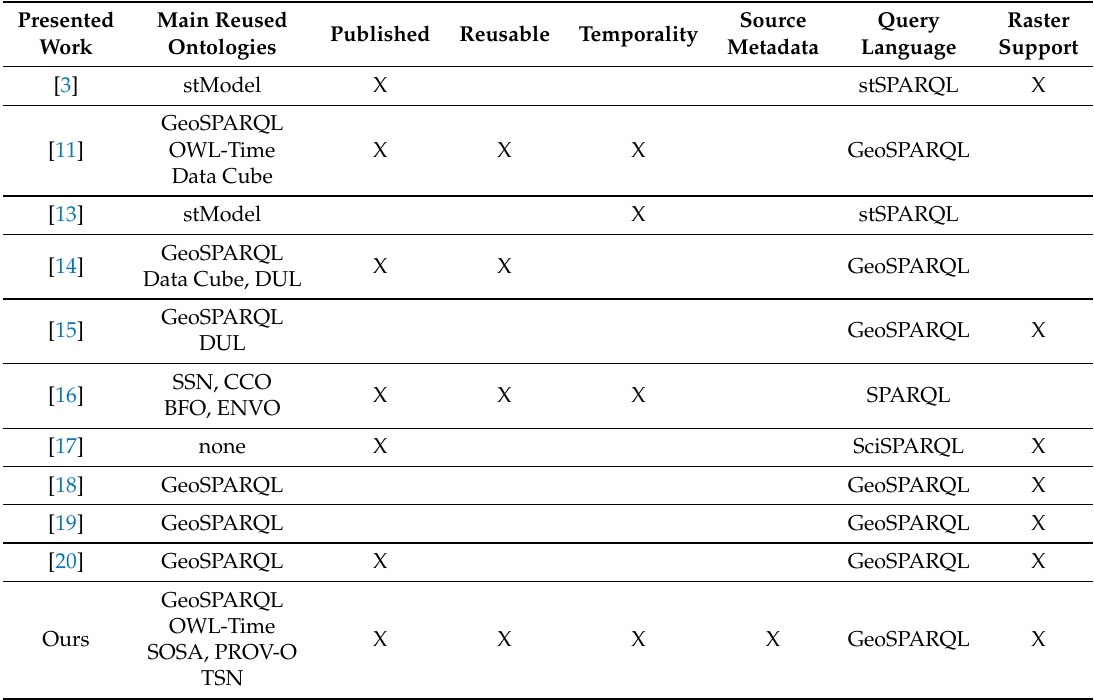
Table 1. Comparison of semantic model for Earth Observation (EO) data integration/representation.